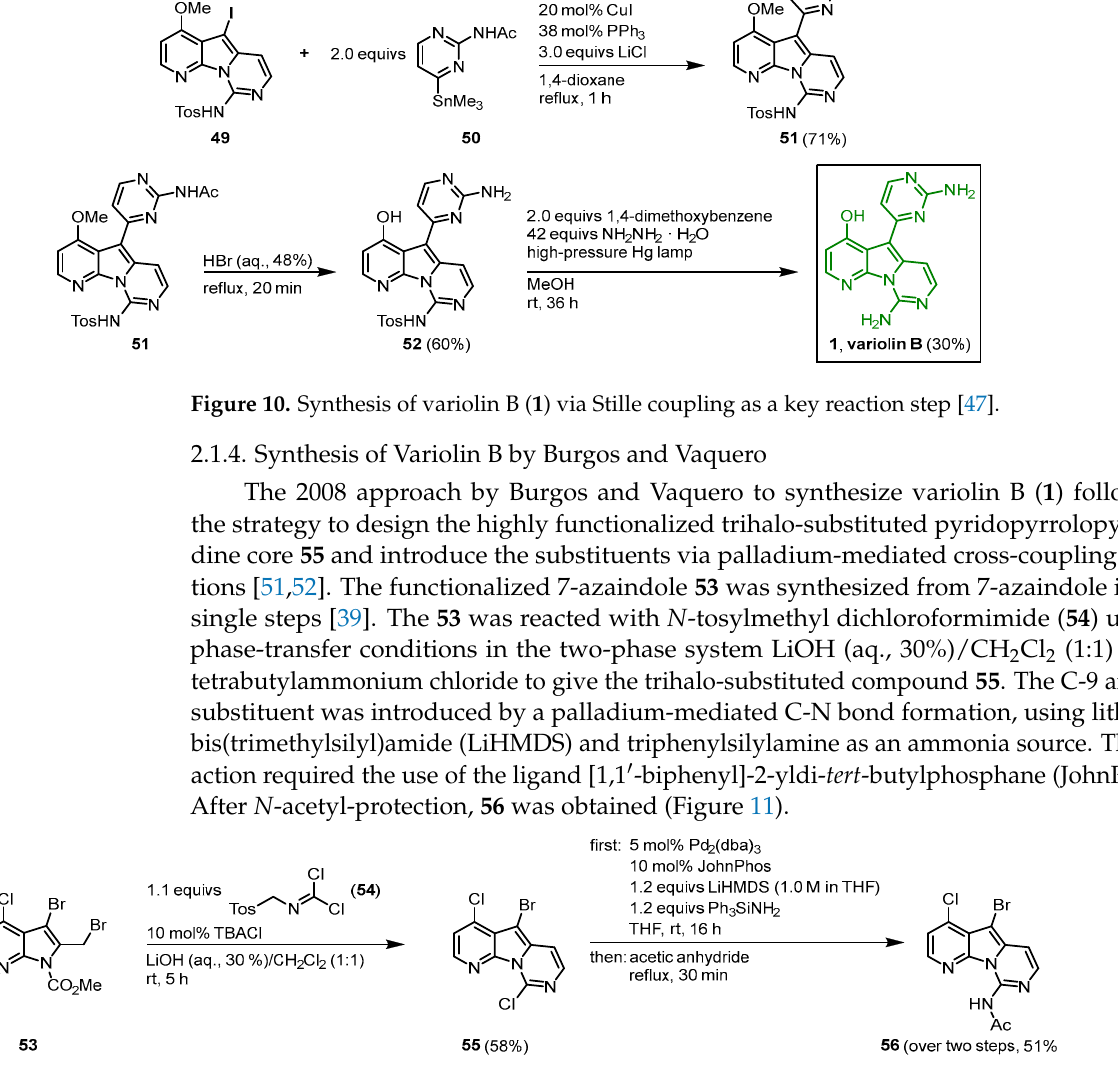
Figure 9. Synthesis of the key intermediate iodide 49 [47].